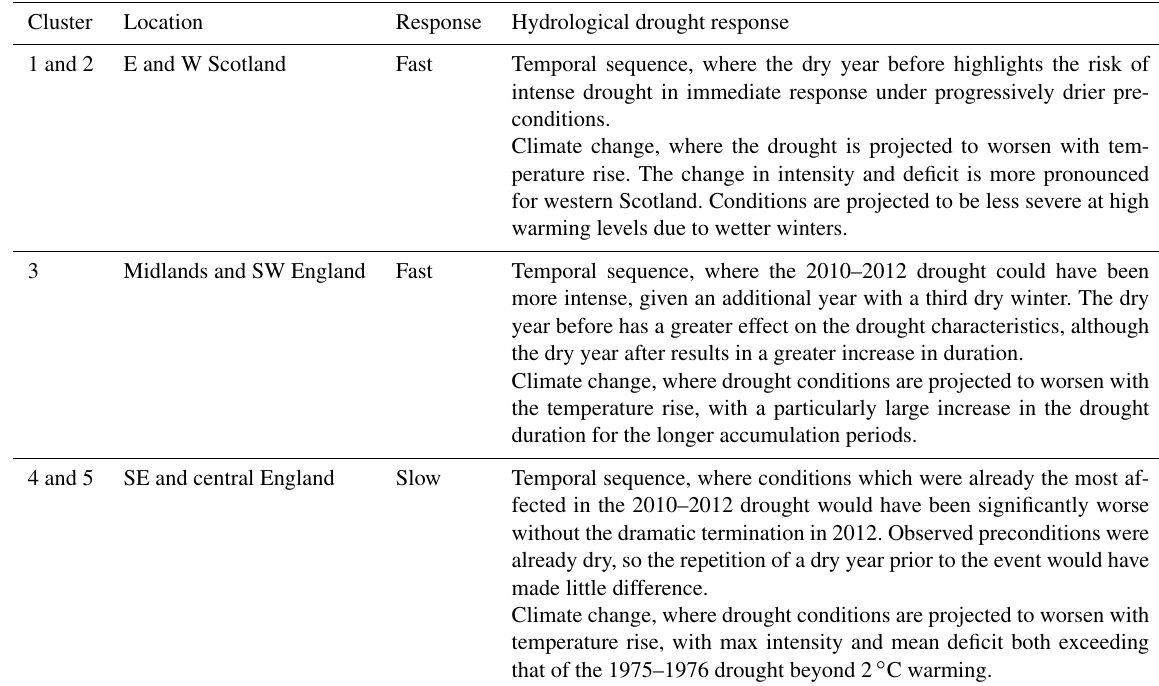
Table 4. Summary of drought response for fast- and slow-responding catchments in the storylines of temporal sequence and climate change. Cluster Location Response